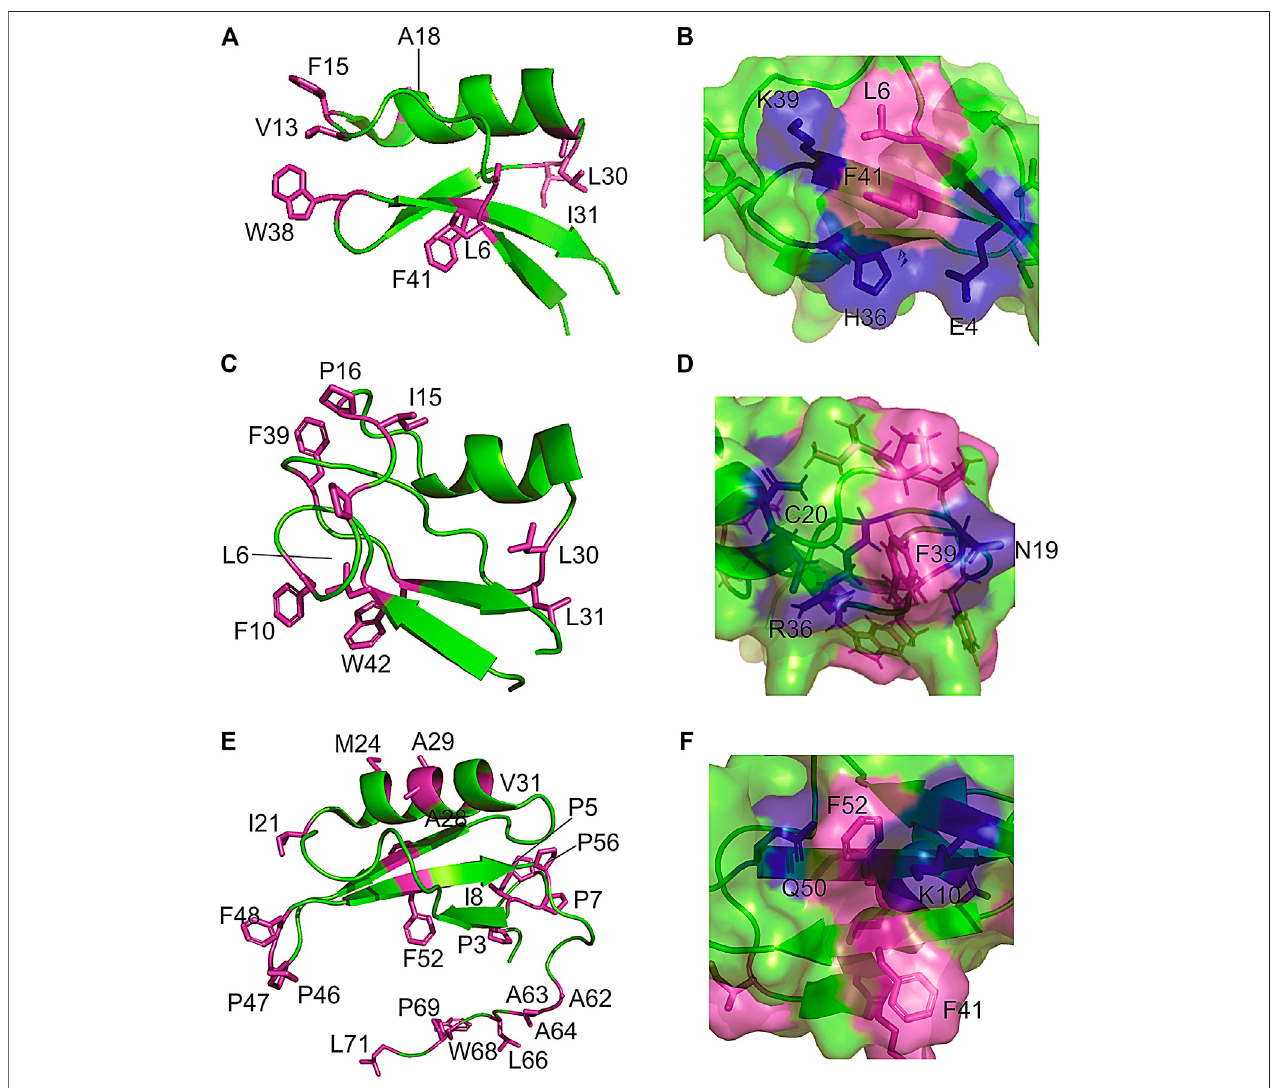
FIGURE 2 | Examples of hydrophobic residues exposing to solvent forming a hydrophobic/hydrophilic surface cluster in plant defensins. The extended and hydrophilic side chains of some amino acids are showing to protect the surface patch in (A,B) plant defensins Psd1; (C,D) Psd2; and (E,F) Sd5.